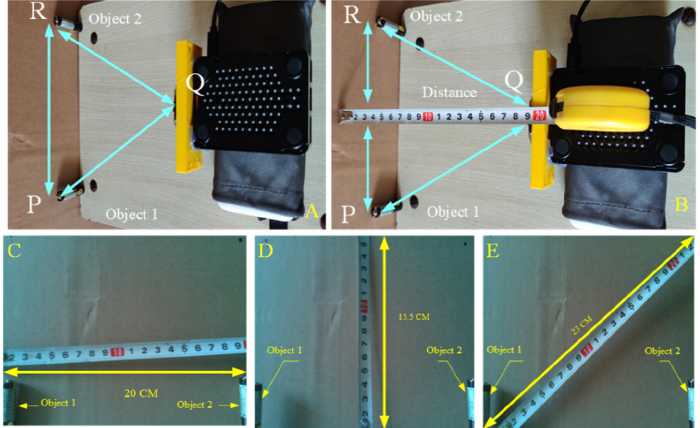
Figure 8. Indoor setup for horizontal, vertical, and diagonal FOV extraction from a fixed distance. ( A ): Distance between fixed object and camera, ( B ): Real Horizontal Length measurement, ( C ): Hori- zontal lengths inside the obtained image, ( D ): vertical lengths inside the obtained image, ( E ): diagonal lengths inside the obtained